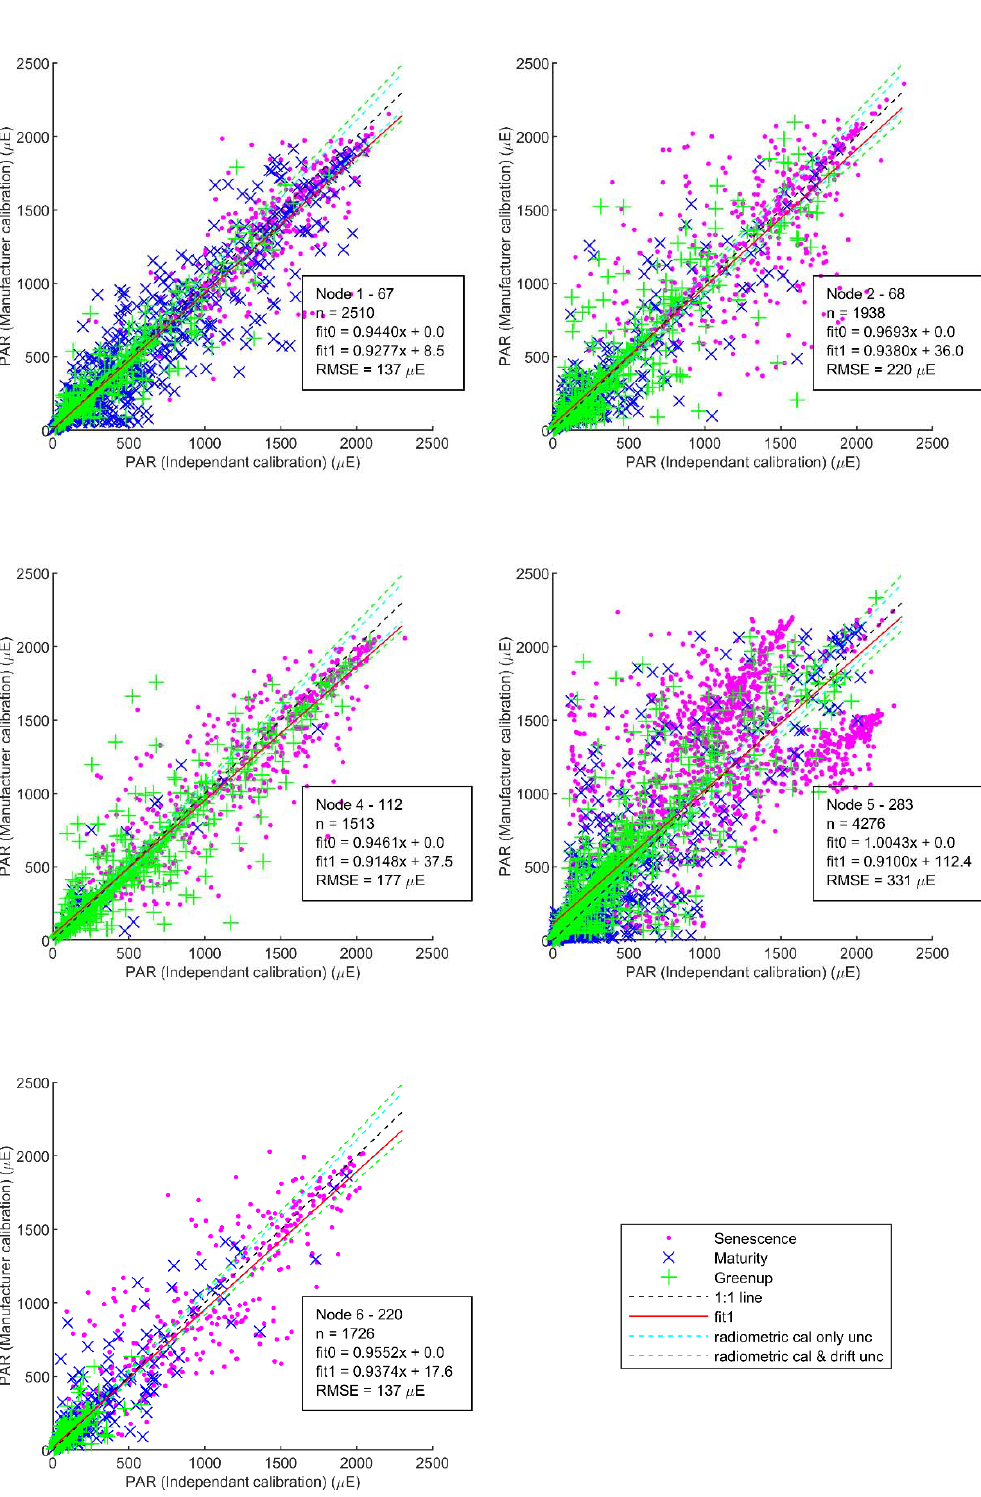
Figure 4. A one-to-one comparison between the co-located PAR sensor pairs. In all plots, the red line indicates the linear regression (fit1) between the sensors at each node, whereas the black dotted line indicates a 1:1 line. The x axis labeled “independent calibration” refers to NPL calibrated sensors, and the y-axis, labeled ‘manufacturer calibration’ refers to the Apogee calibrated sensors. The green symbols are ‘green-up’, blue are ‘maturity’, and magenta are ‘senescence’. For each node, the inner cyan dashed lines denote the combined calibration uncertainty range, whereas the outer green dashed lines are the calibration and drift terms. The type ft0 corresponds to a 0 forced linear regression, and ft1 corresponds to a 1:1 forced linear